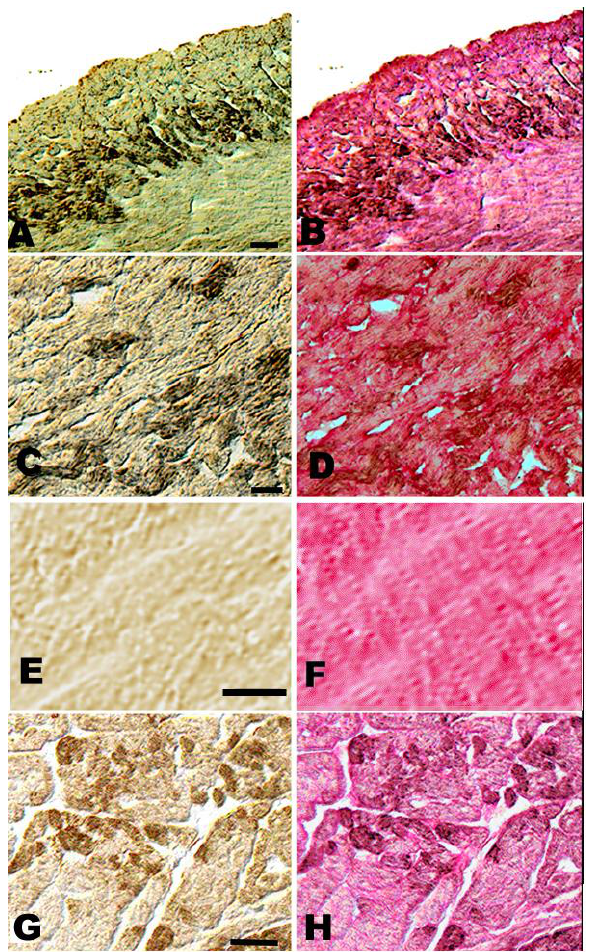
FIGURE 4. Immunohistochemistry identifying transplanted cells and cardiophenotypic proteins. Immunofluorescent techniques for antigen detection were not used due to the high degree of autofluorescence characteristic of fixed cardiac muscle that has led to some recent experimental misinterpretation. Immunohistochemistry was performed to identify transplant-derived cells expressing GFP (left panel: black/brown staining; A,C,G), and subsequently cardiophenotypic proteins (right panel, red staining). (B) Striated tropomyosin, (D) cardiac troponin I (H), sarcomeric α-actin. (E,F). Serial sections showing a negative (E, no primary antibody) and a positive control (F) for cardiac troponin I. Bar: 20 